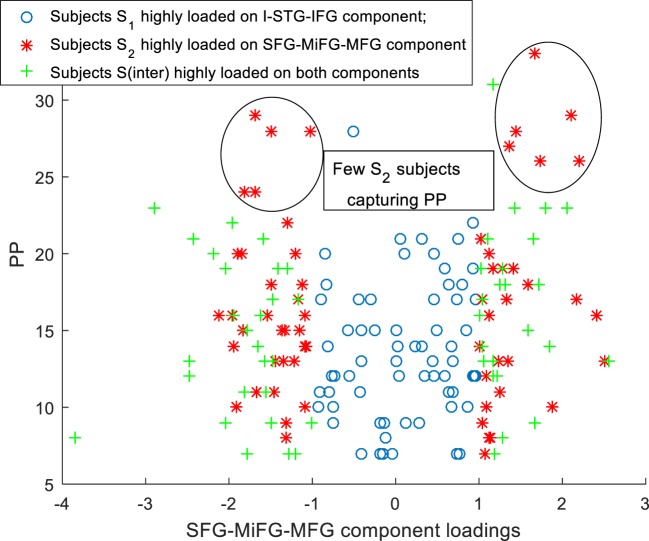
Scatter plot for subtypes S1, S2, Sinter SFG-MiFG-MFG component loadings Vs PP.